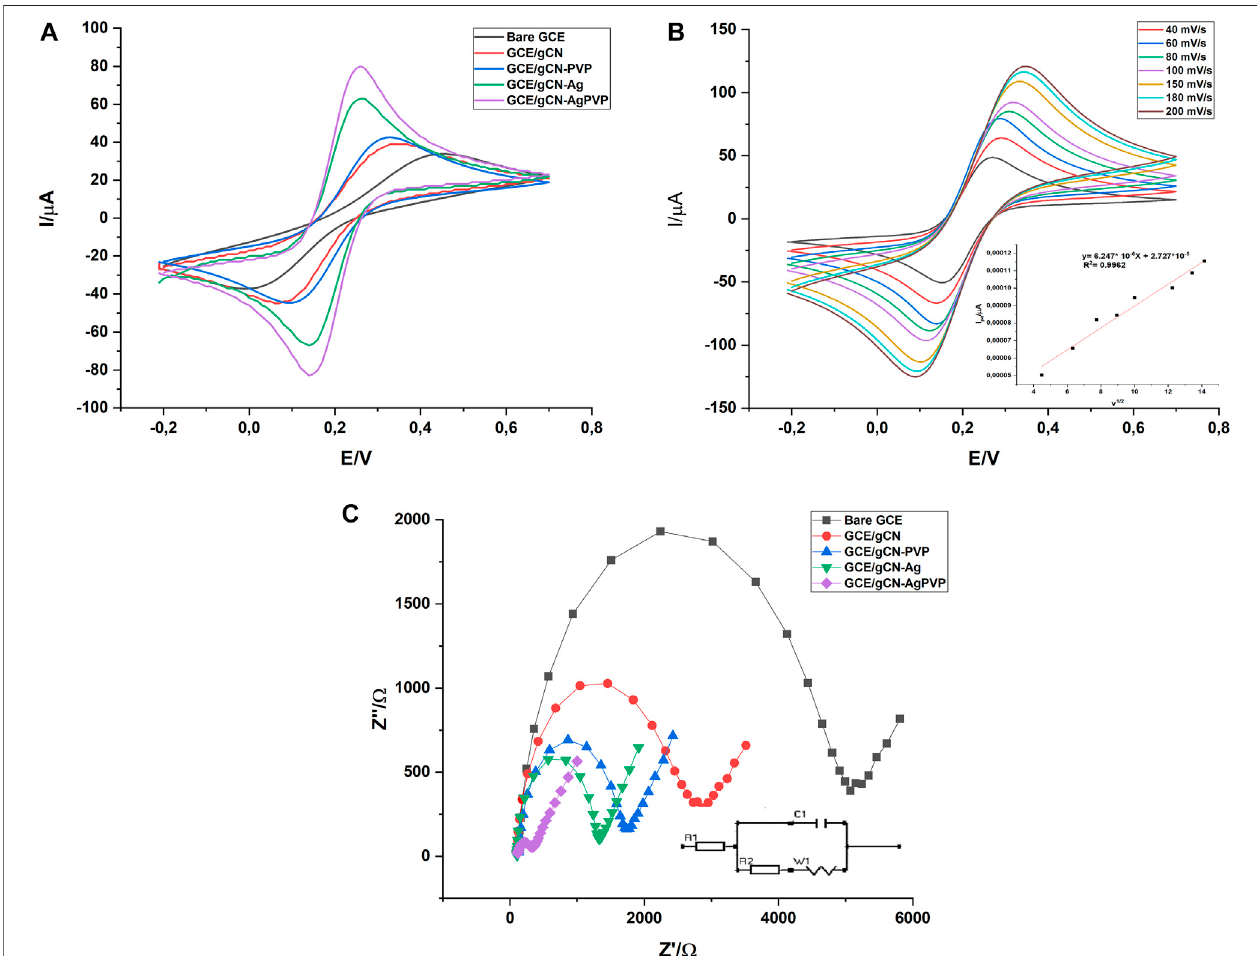
FIGURE 4 | (A) CV of the bare, GCE-gCN and GCE-gCN-AgPVP in the presence of 0.1M KCl solution containing 5 mM [Fe(CN) 6 ] 3-/4 at scan rate 0.05 Vs − 1 . (B) ScanratestudyofGCE/gCN-AgPVP inthepresenceof0.1MKClsolutioncontaining5